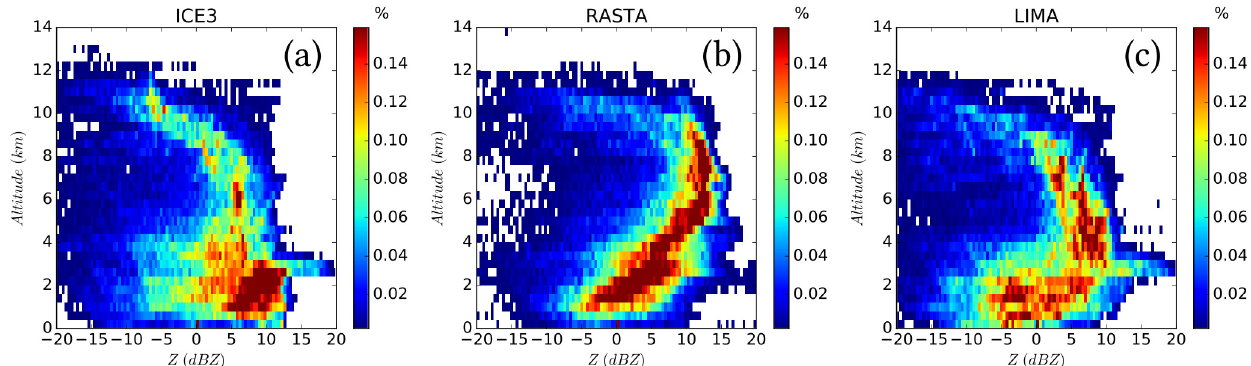
Figure 6. Distribution of simulated ( a : ICE3, c : LIMA) and observed (b) RASTA reflectivities sorted by temperature, merging data from IOP6 and IOP16a (from Taufour et al., 2018